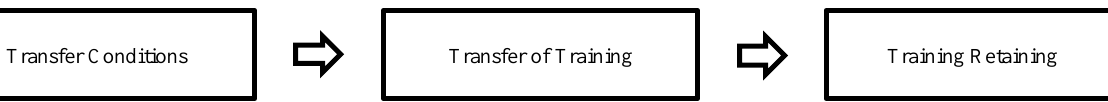
Figure 2: A conceptual framework; Source: Developed by the